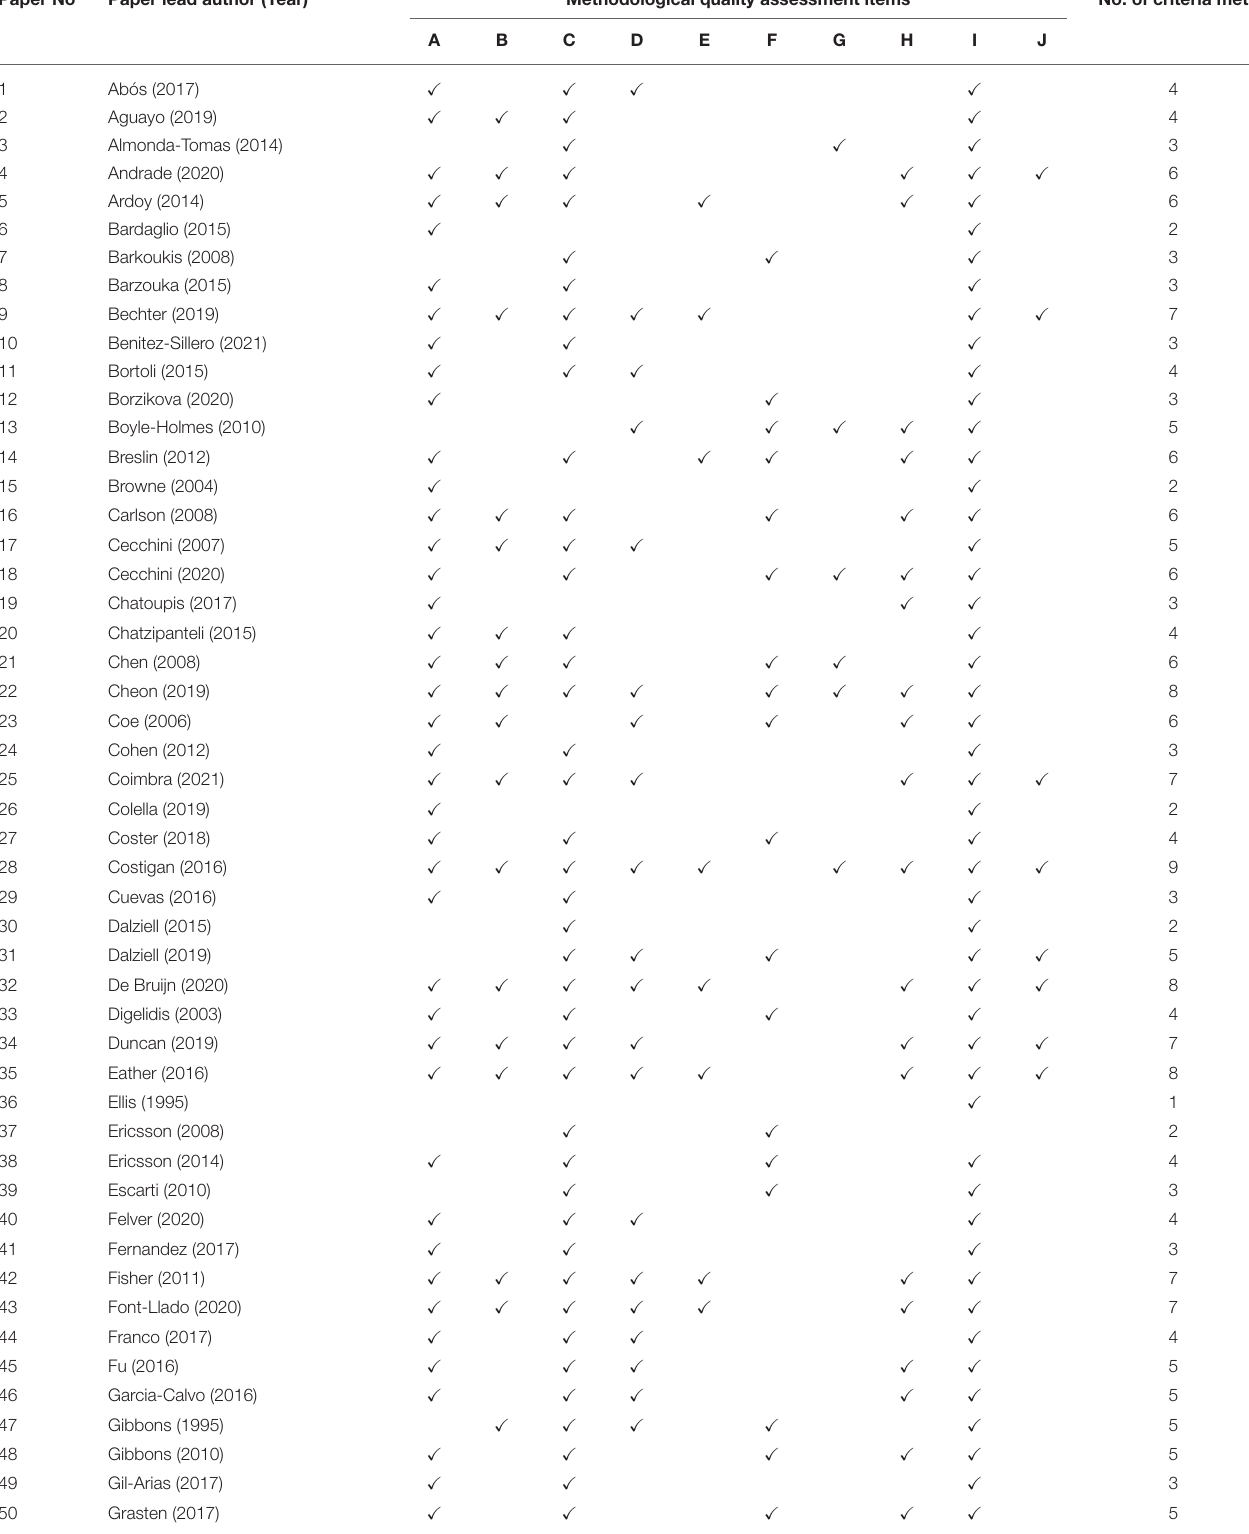
TABLE 3 | Results of methodological quality